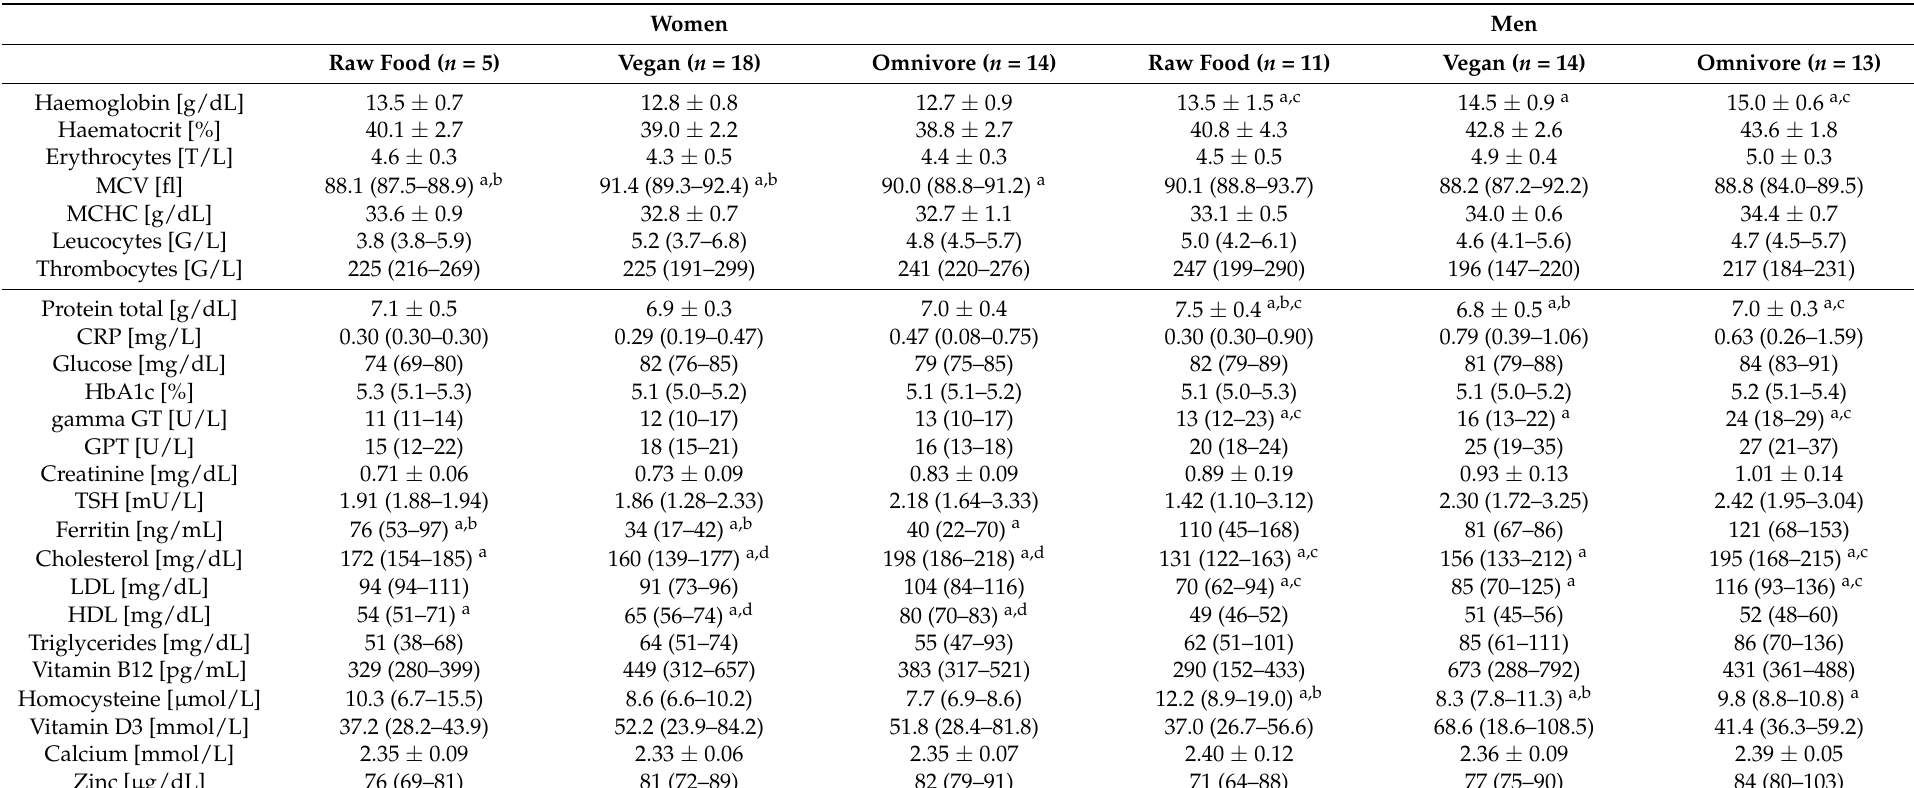
Table 3. Laboratory blood and serum parameters of women and men of raw food eaters, RBVD vegans and RBVD